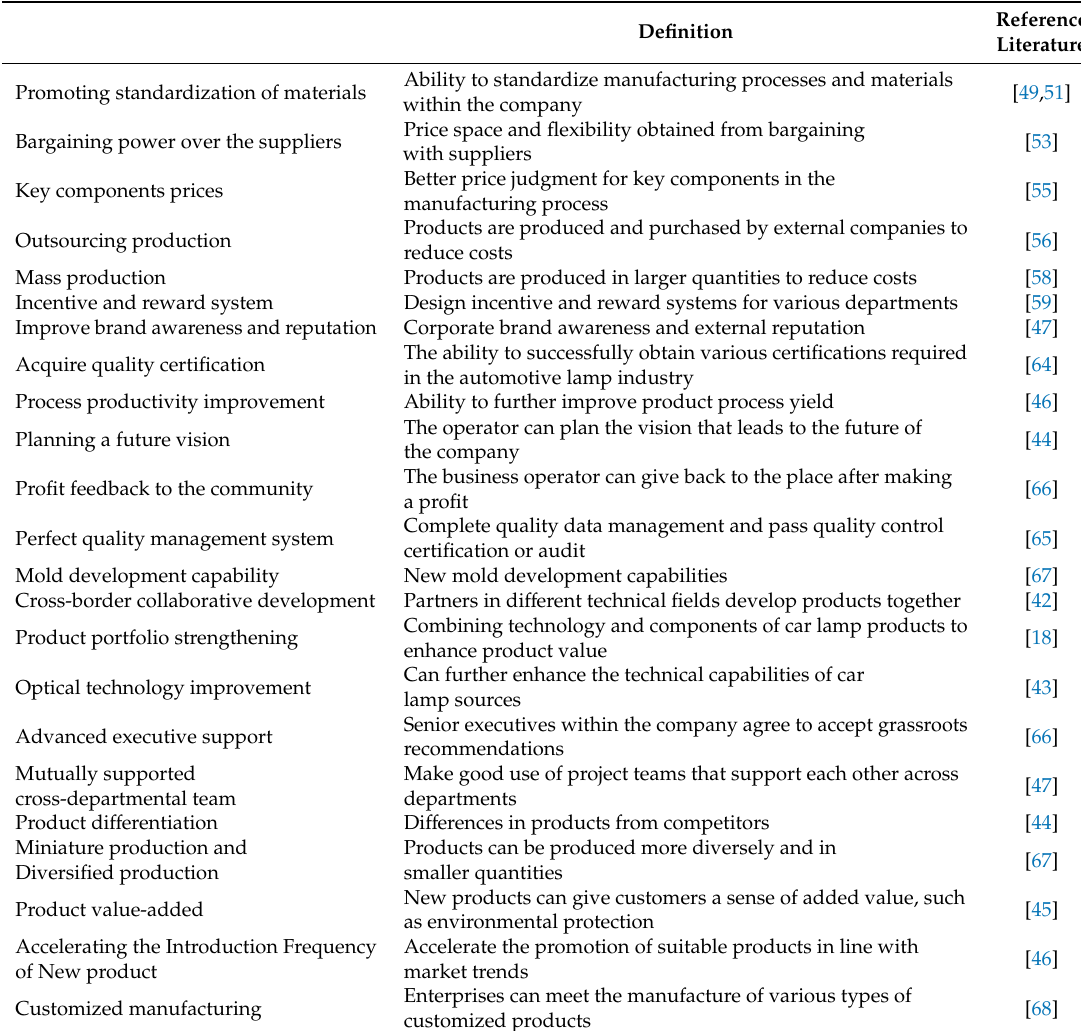
Table A1. The definition of KSFs of the auto lighting aftermarket